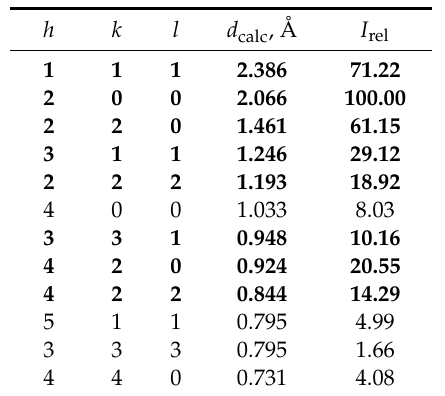
Table 3. Calculated powder di ff raction data for